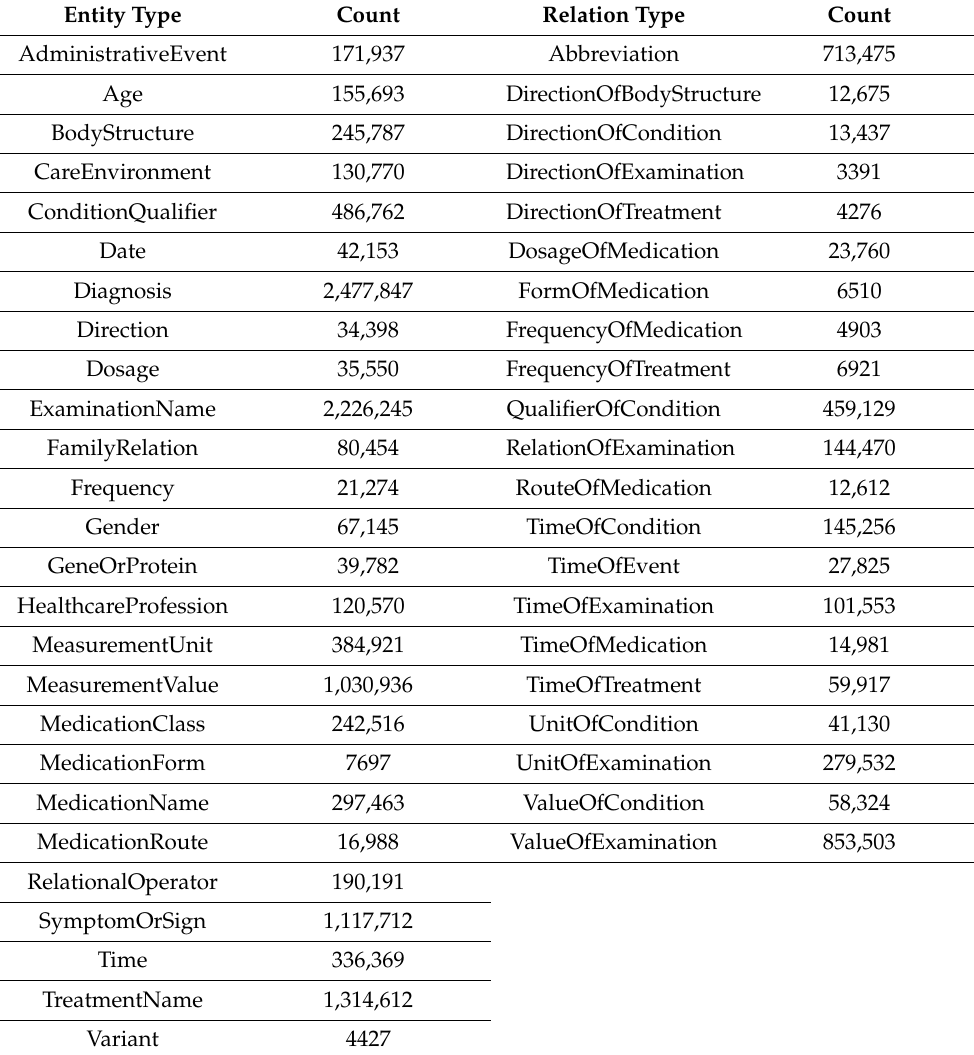
Table 1. Entity and relation types extracted by Text Analytics for Health and the number of their occurrences in the papers dataset.